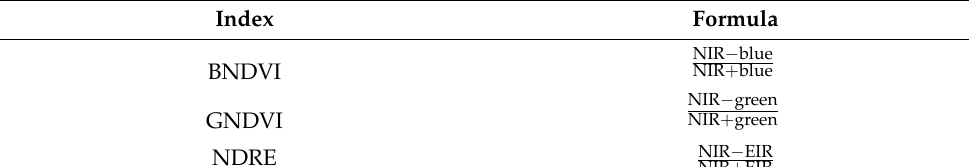
Table 2. Vegetation indices for online extension of MUCAD.